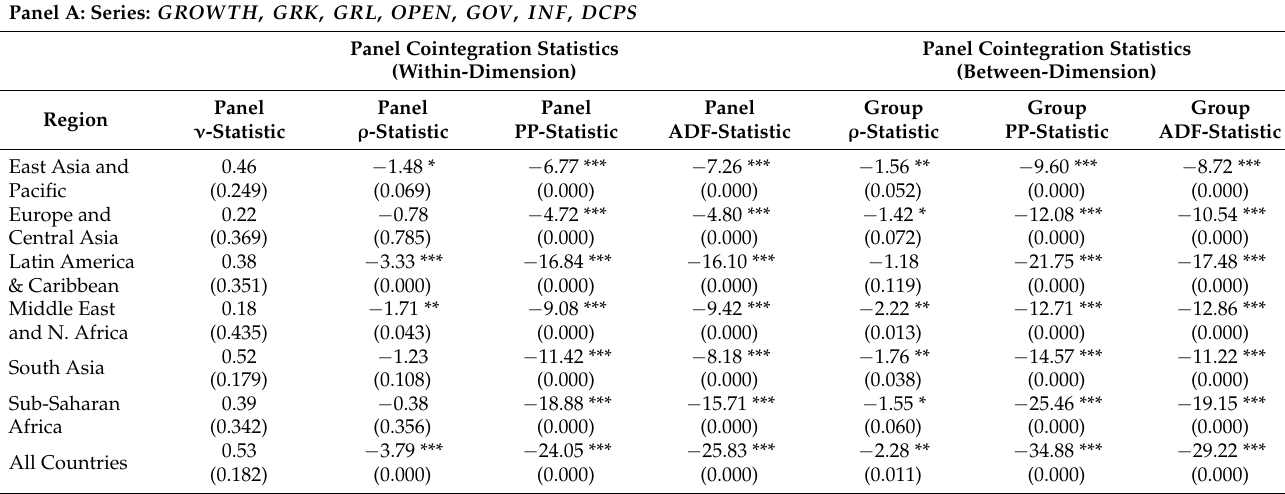
Table A1. Pedroni’s Heterogeneous Panel Cointegration